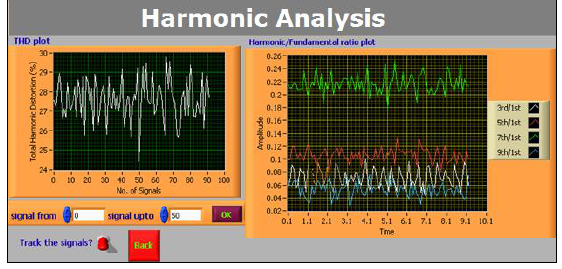
Figure 19. The front panel of FFT based THD and Harmonic analysis.